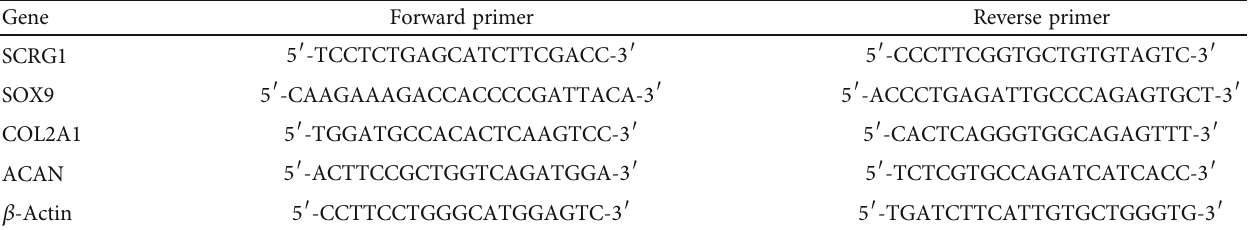
Table 2: Primer sequences used in this